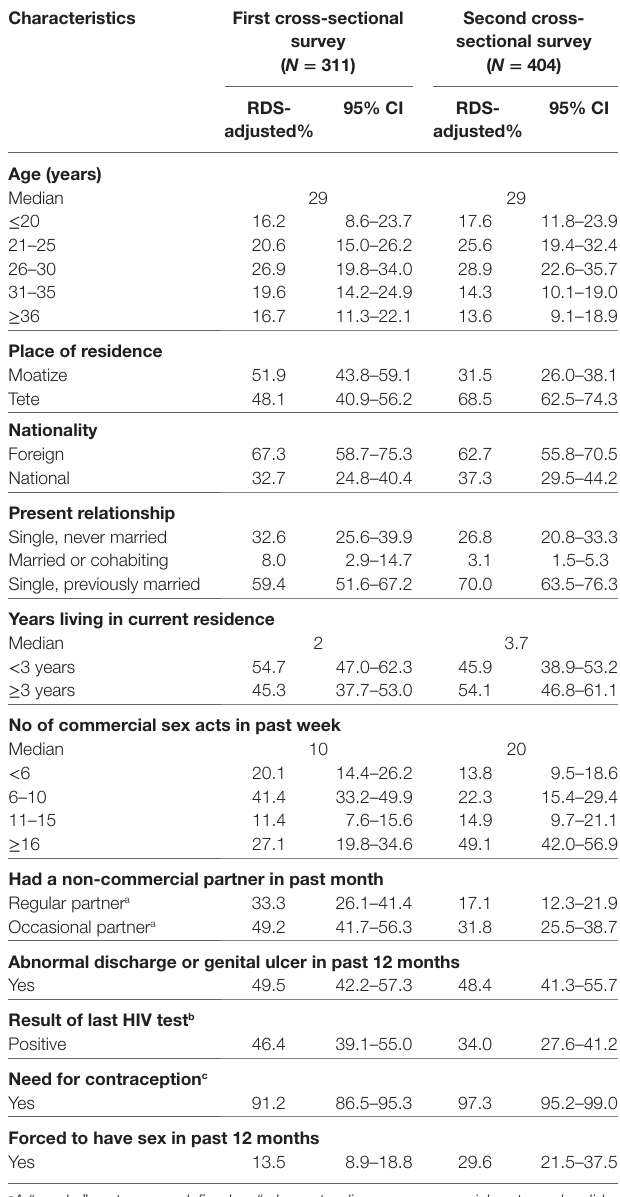
TaBle 1 | Characteristics of study participants in the pre- and post-intervention surveys.